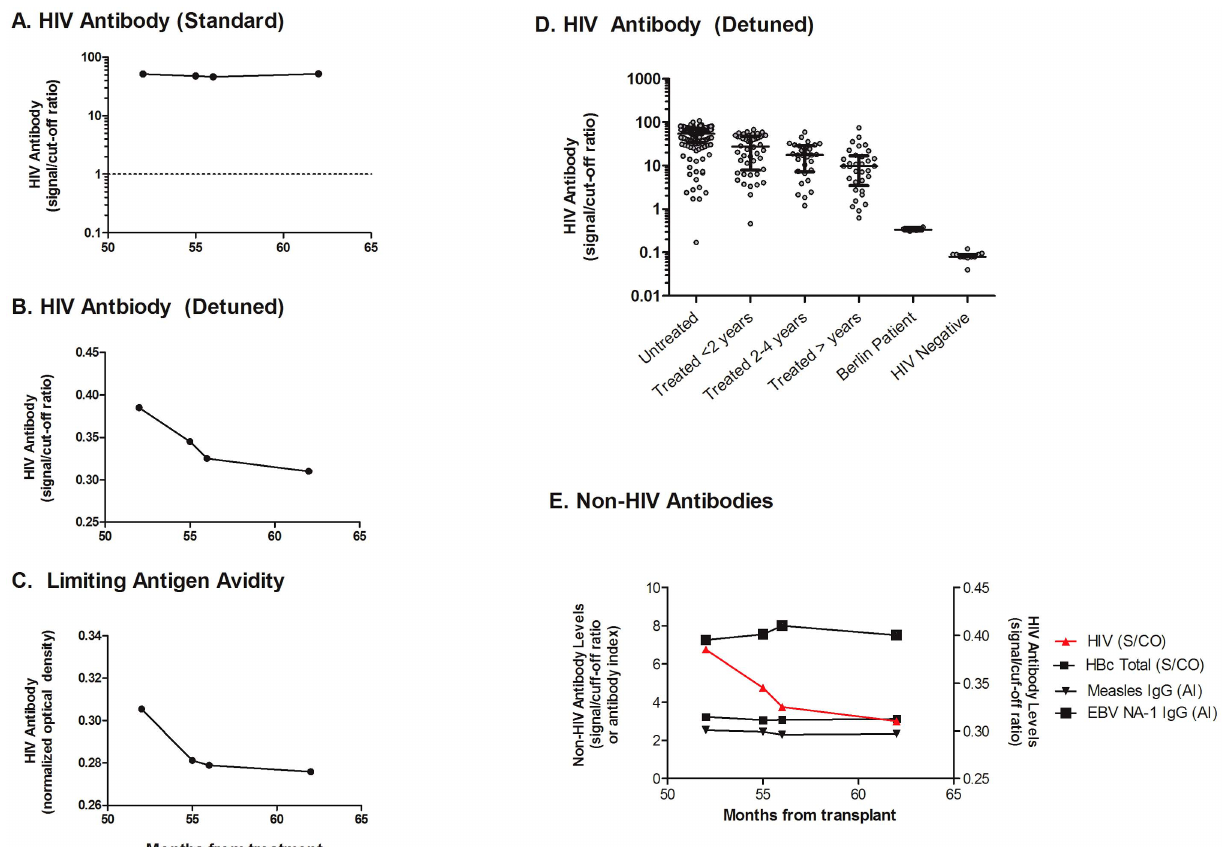
Figure 3. HIV-specific antibodies. Blood from four time points was tested for HIV specific antibody levels using the HIV-1/2 VITROS assay (3A), a detuned version of the HIV-1 VITROS assay (3B), and the Limiting Antigen avidity assay (3C). The y-axis shows the relative level of total HIV-specific antibody, as expressed as the signal to cutoff ratio (3A–B) or normalized optical density, ODn (3C). The x axis represents months since transplant. In Figure 3A, the dotted line represents the diagnostic HIV antibody assay cut-off level used to classify individuals as HIV-positive or HIV-negative. For purposes of comparison, HIV antibody responses were also measured in HIV-uninfected adults, untreated HIV-infected adults, and ART-treated chronically-infected adults using the detuned HIV-1 VITROS assay (Figure 3D). The bars in the scatterplots represent the median and interquartile ranges of distributions of seroreactivity for each group. Finally, samples from the Berlin Patient were tested for antibodies to other infectious diseases (3E). Tests included antibodies to CMV (strong positive, above the limit of detection), EBV, measles, and hepatitis B (all within the range of detection) as well as VZV, mumps, rubella, and toxoplasmosis (all negative, below the limit of detection). Only the results within detectable range of the assay are shown. S/CO=signal/cutoff ratio; ODn=normalized optical density; AI=antibody